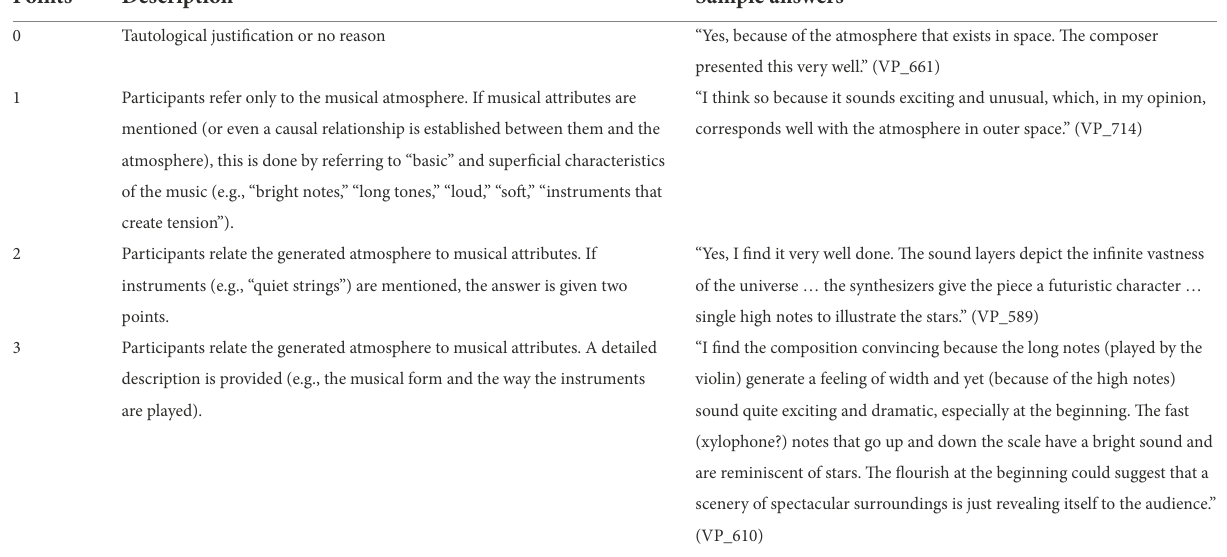
TABLE 1 Coding scheme for the sample item “star